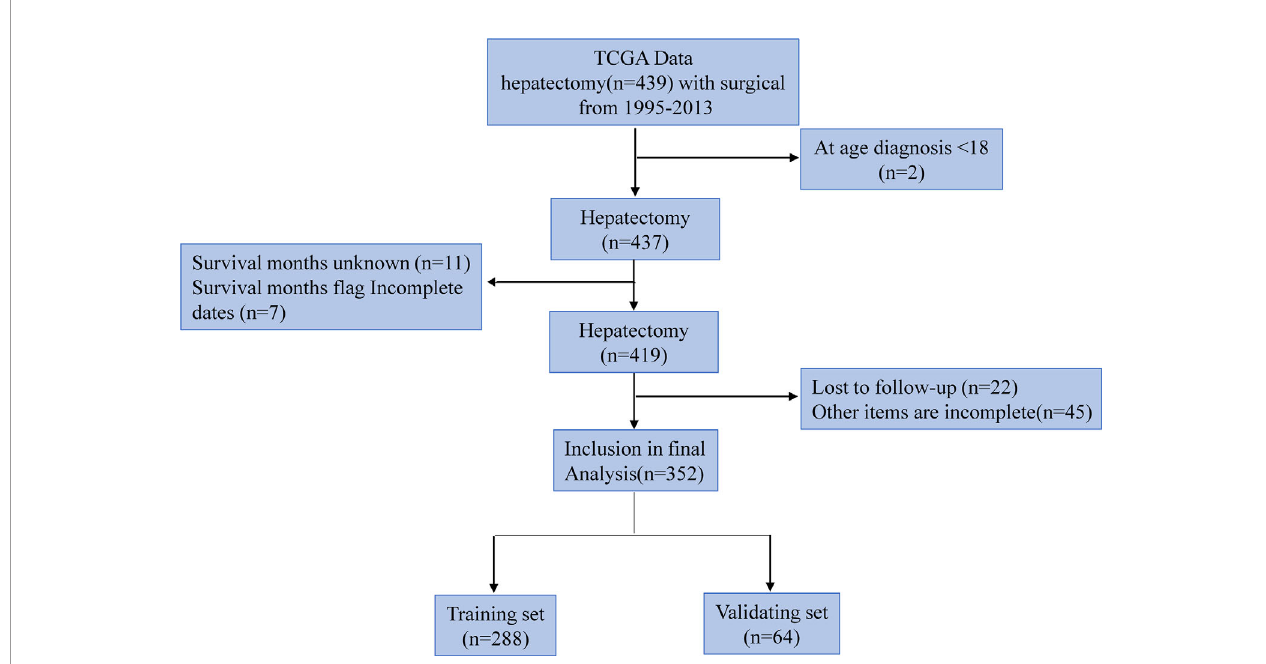
FIGURE 1 | Numbers of patients enrolled and outcomes in the training set and validating